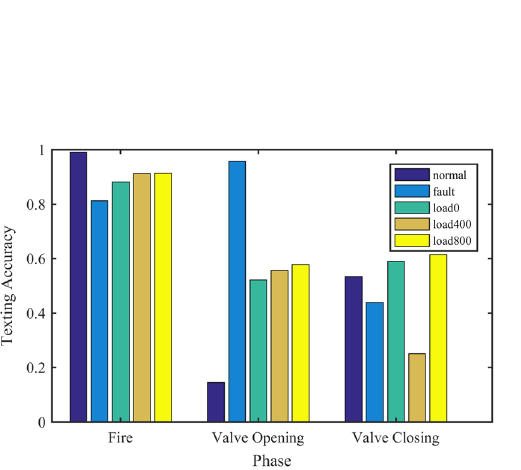
Figure 10. Attention weight summarized in the working